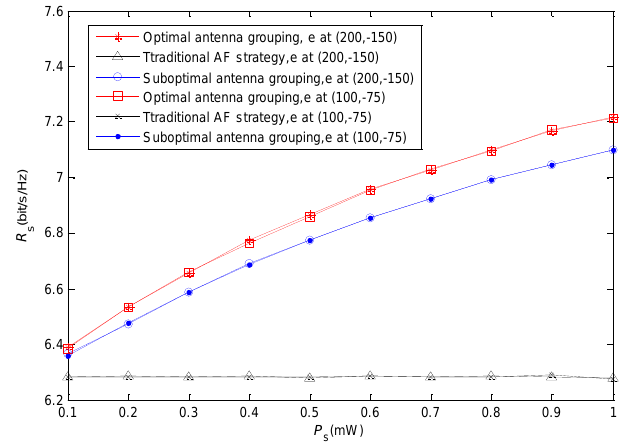
Figure 4. Relationship between source transmission power and secrecy rate.